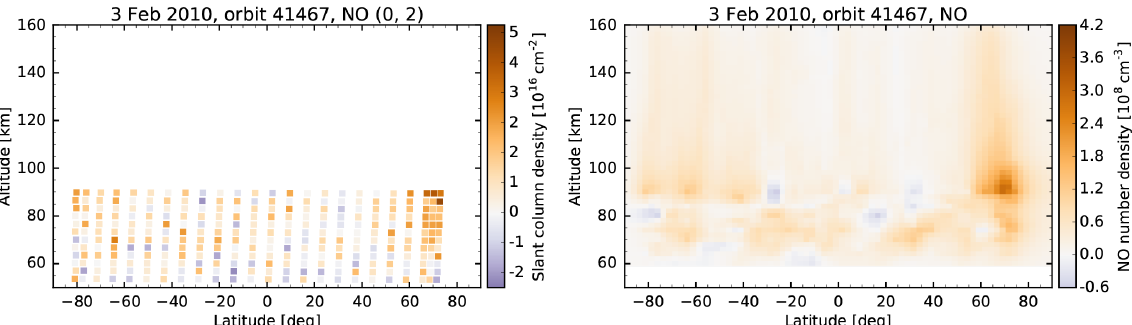
Figure 2. Results from the SCIAMACHY MLT sample orbit (no. 41467, 3 February 2010) restricted to the 50–91km limb tangent points. NO slant column densities for the (0, 2) transition (left) and the retrieved NO number densities without a priori input